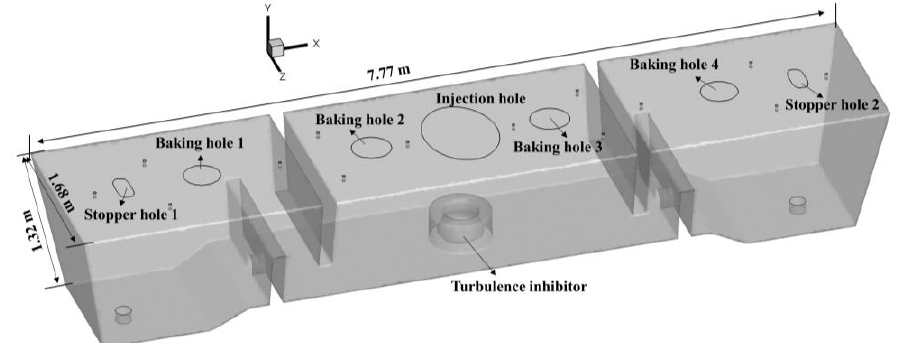
Figure 1. Structure diagram of a two-strand slab tundish. Figure 2. Arrangement of the argon blowing pipe on the two-strand slab tundish cover (mm).